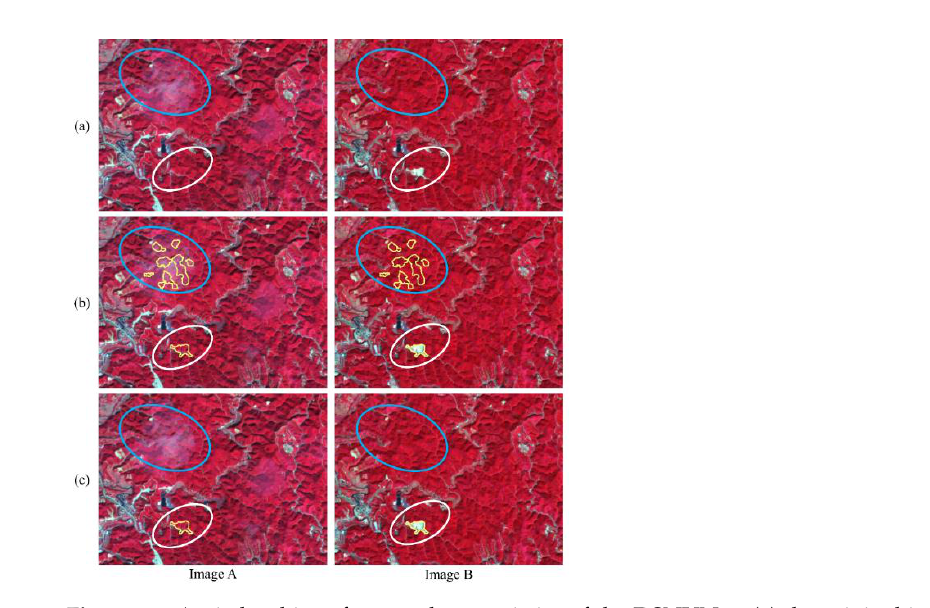
Figure 13. Anti-cloud interference characteristics of the DSNUNet: ( a ) the original image; ( b ) the prediction result of the SNUNet; ( c ) the prediction result of the DSNUNet. The blue and white circles denote the cloud areas and true change areas, respectively. The yellow area is the predicted result of SNUNet and DSNUNet.